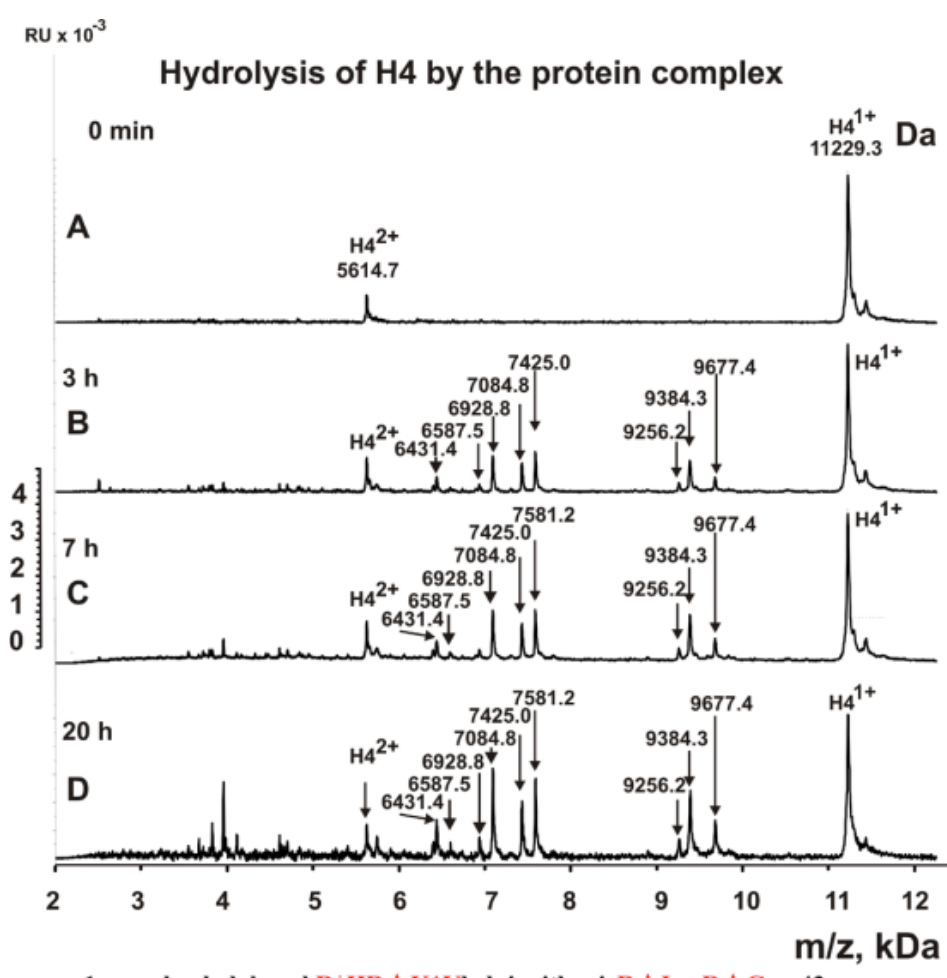
Figure 4. MALDI spectra correspond to H4 histone (0.8 mg/mL) over time hydrolysis in the presence of sea cucumber stable complex (0.15 mg/mL or 7.5 × 10 − 8 M). Major cleavage sites are indicated by large stars ( ★ ), moderate sites by arrows ( ↓ ), and minor sites by colons (:) ( A – D ). Below the spectra, the protein sequence of histone H4 and the sites of its hydrolysis by the stable complex are shown. Aromatic residues of the protein sequence are marked in grey, after which no histone hydrolysis is observed. RU: relative values.